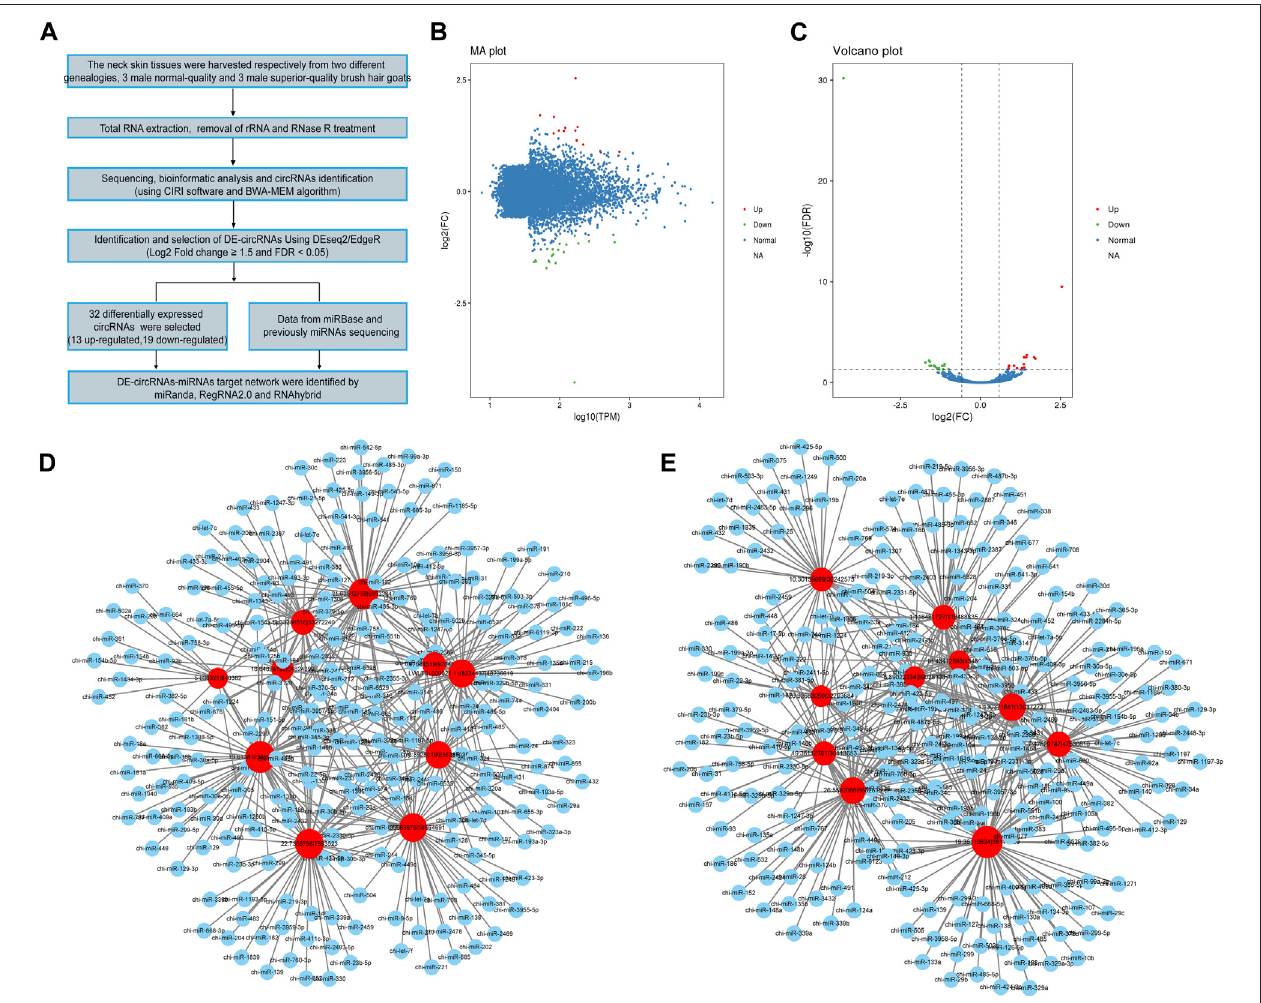
FIGURE1| DifferentialexpressioncircRNA-miRNAnetworkconstructionandanalysis. (A) Thumbnailofthedataanalysis. (B,C) MAplot (B) andvolcanoplot (C) of 32 differentially expressed circRNAs between NQ and SQ goats selected based on a log2-fold change ≥ 1.5 and FDR < 0.05. (D) Diagram of the top 10 upregulated circRNA-miRNA interaction networks. (E) Diagram of the top 10 downregulated circRNA-miRNA interaction networks. (F) Heatmap of 32 differentially expressed circRNAs identi fi ed by comparing NQ and SQ goats. (G) KEGG analysis of the host genes of differentially expressed circRNAs.